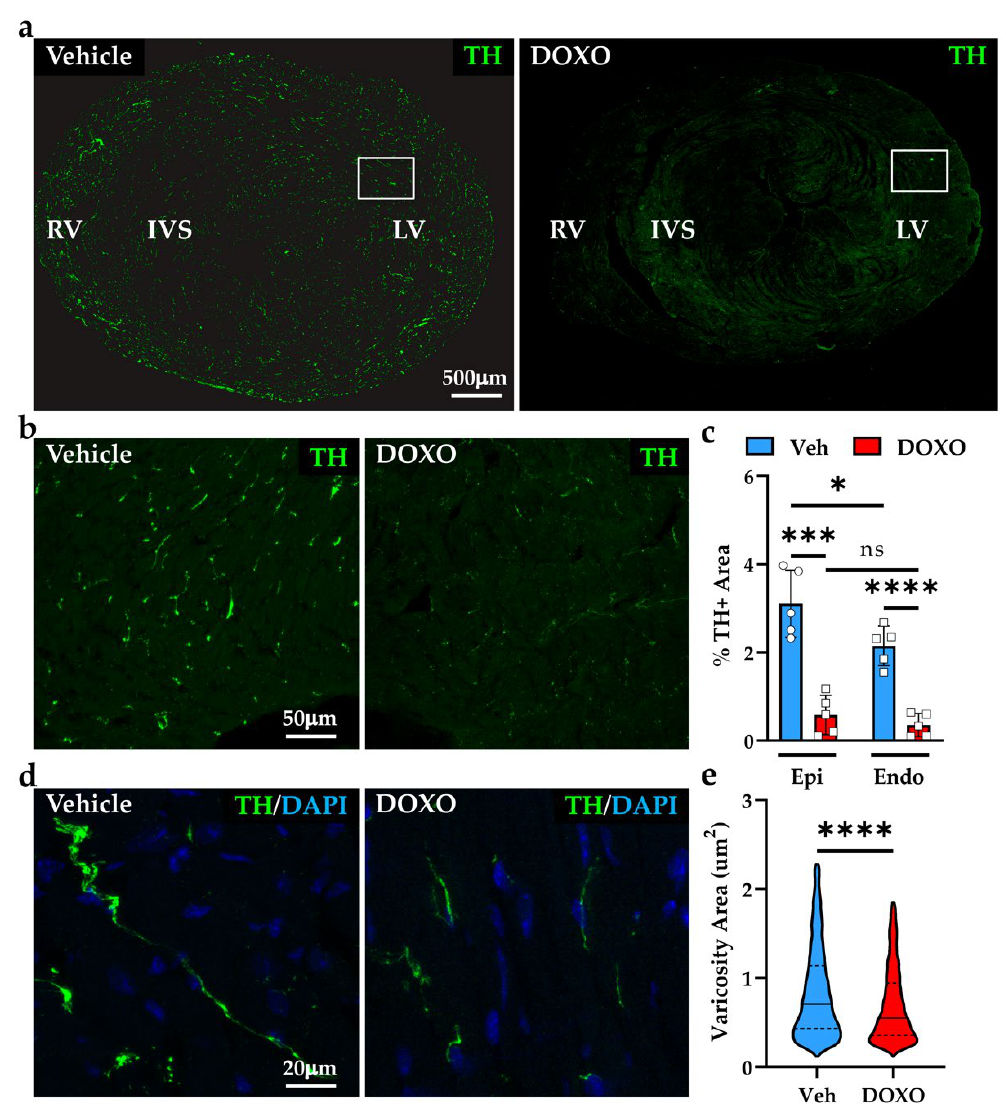
Figure 4. DOXO treatment causes cardiac sympathetic denervation in mice. ( a ) Confocal immuno- fluorescence on heart sections from the ventricular mid-portion of vehicle- vs. DOXO-treated mice. Sections were stained with an antibody to tyrosine hydroxylase (TH). ( b ) Images are high magnifi- cation of the white boxed areas in ( a ). ( c ) Quantification of the percentage of TH-positive area in the sub-epicardial (Epi) and sub-endocardial (Endo) LV myocardium of the control (Veh) and DOXO hearts. Each point represents the average tyrosine hydroxylase positive (TH+) area of 20 independ- ent images from the Epi and Endo regions in five hearts analyzed/group. Bars represent the s.d. Differences among the groups were determined using an unpaired t -test (*, p < 0.05; ***, p < 0.001; ****, p < 0.0001; ns, no significant). ( d ) High magnifications of SN processes in the LV of control and DOXO hearts. ( e ) Quantification of sympathetic neuron (SN) varicosity area. Differences among the groups were determined using a Mann–Whitney test. (n > 1000 varicosities from five different hearts